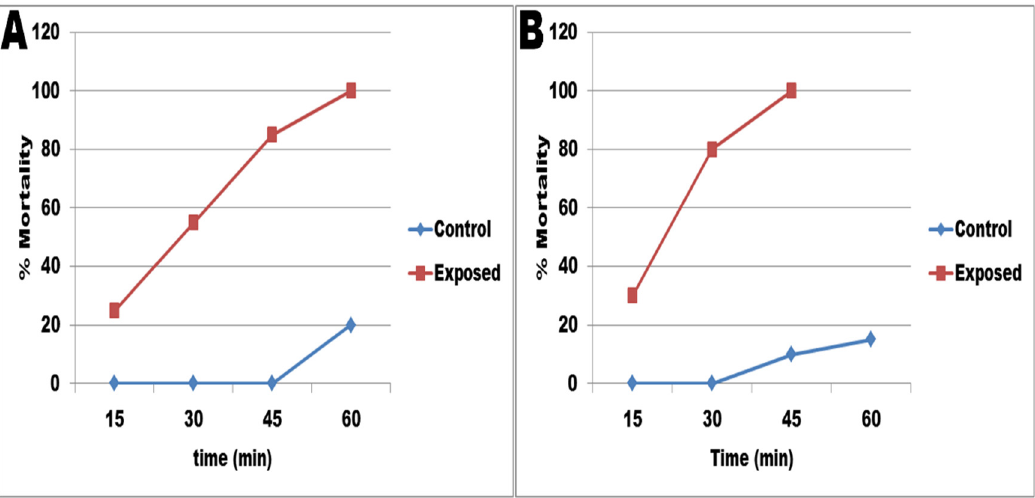
Figure 7. The miracidicidal ( A ) and cercaricidal ( B ) activities of SeNPs.